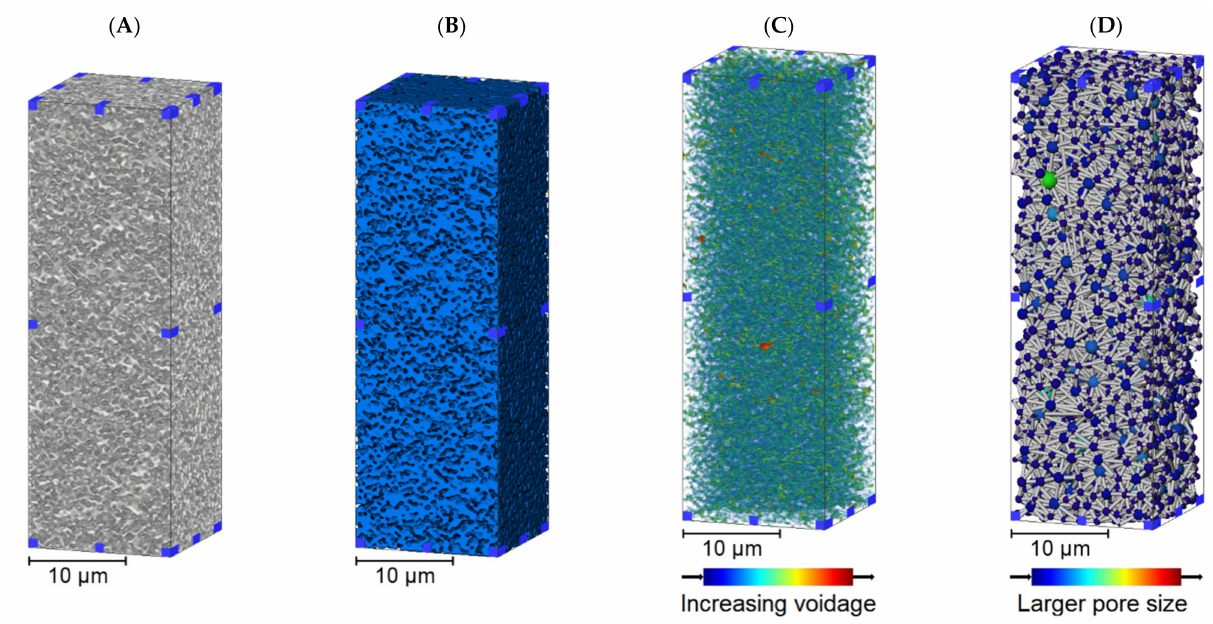
Figure 3. The 3D subvolume renders of the downstream membrane from X-ray CT imaging. ( A ) A 3D render of an imaged subvolume. ( B ) A 3D render of the subvolume following segmentation with blue representing the material phase. ( C ) Voidage distance map displaying the largest spaces within the subvolume. ( D ) Pore Network Modeling within the subvolume.